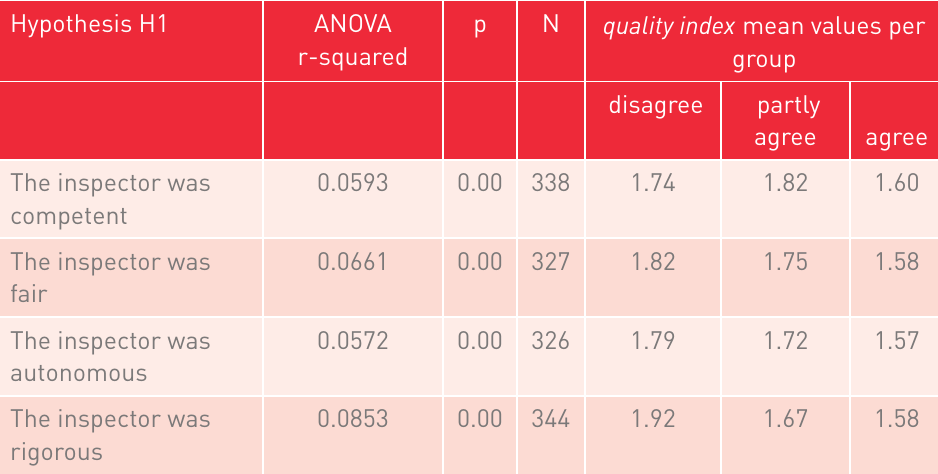
Perception of building quality (mean values), in relation to impression of an